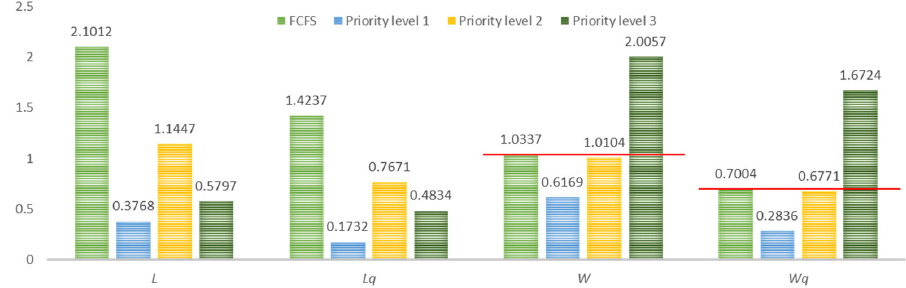
Figure 5. Comparison of performance indicators: FCFS rule vs. non ‐ preemptive priorities.